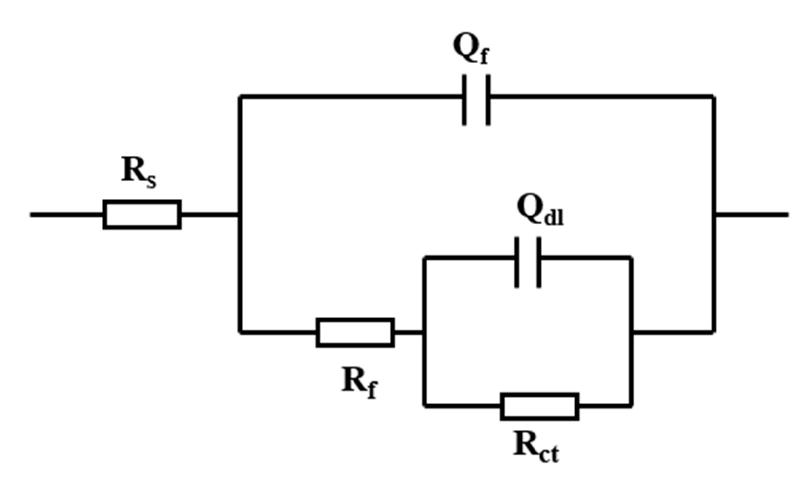
Figure 4. Schematic diagram of equivalent circuit derived from EIS results. Table 2. R ct values obtained by EIS fitting of magnesium alloy AZ31B immersed in 3.5% NaCl solution with different concentrations of S 2 − .